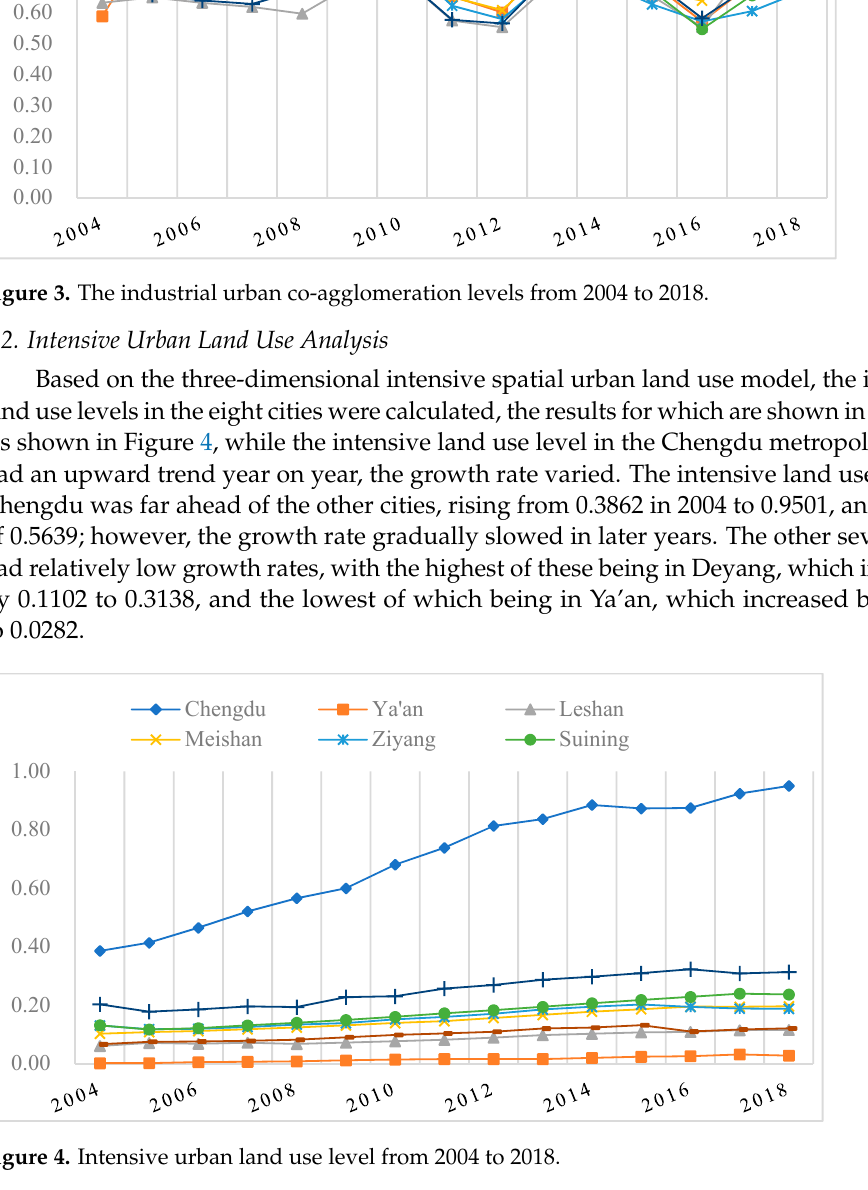
Figure 5. Average intensive urban land use from 2004 to 2018. 3.3. Coordinated Coupling Relationship Analysis Using Formulas (4)–(6), a comprehensive measurement of the coupling coordination level between the industrial urban co-agglomeration and intensive land use was carried out, the results for which are shown in Figure 6. From 2004 to 2018, the coupling coordi- nation degree between the industrial co-agglomeration and intensive land use in the eight Chengdu metropolitan area cities continued to increase, indicating continual improve- ments in the coordination; however, the growth rates varied from city to city.